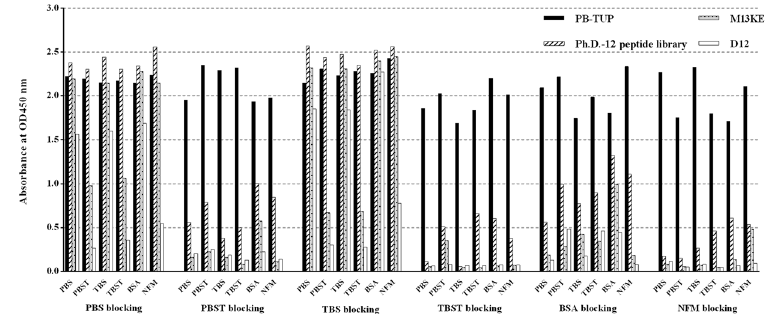
Figure 1. Polystyrene binding of PB-TUP, Ph.D.-12 peptide library, M13KE, and a non-relevant phage clone (D12) determined by ELISA. Four phage clones were added to the microtiter plates and the wells were treated with six different blocking buffers (first line) and six different washing buffers (second line), separately. ELISA values were used to evaluate the binding ability of these four phage clones to polystyrene. NFM had the best blocking effect. PBST and TBST were more effective washing buffers than the others. PB-TUP phage clone always had much higher absorbance comparing with the other phage clones. The experiments were performed in triplicates and repeated